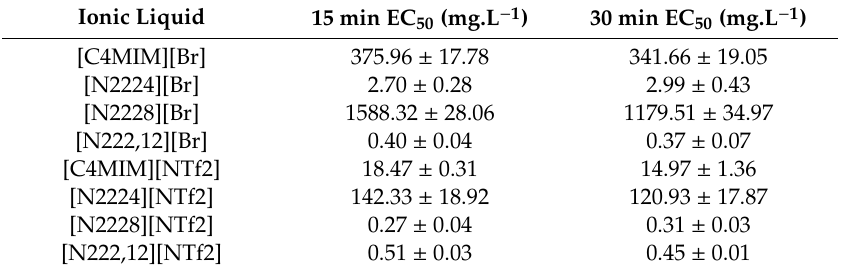
Table 2. E ff ective concentrations and their corresponding standard deviations obtained in Vibrio fischeri